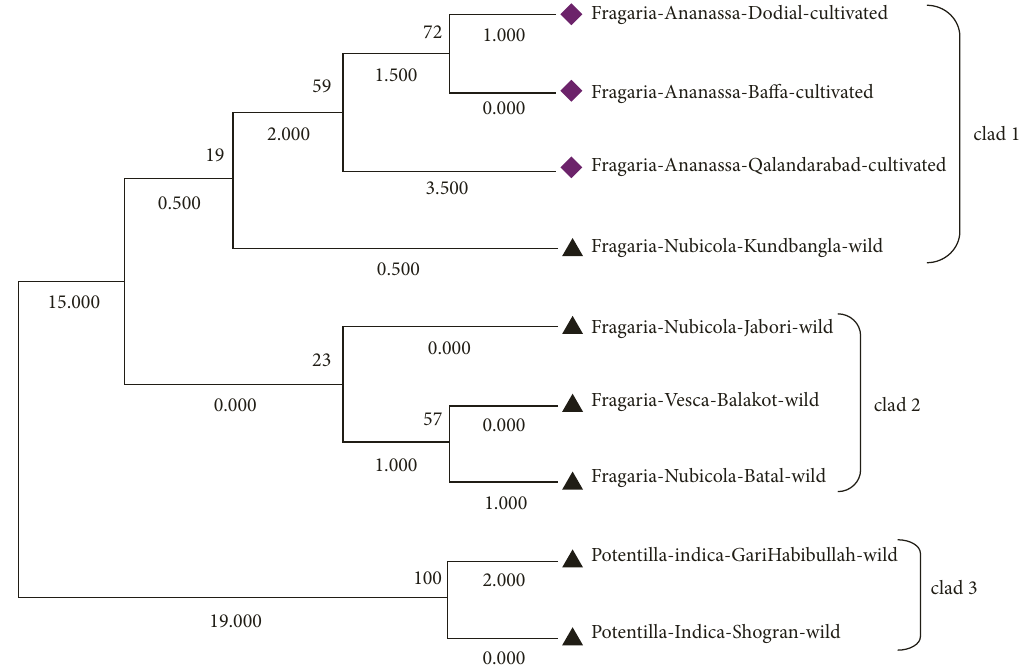
Figure 7: ITS2 -based phylogenetic tree among wild and cultivated Fragaria species through the maximum parsimony method.